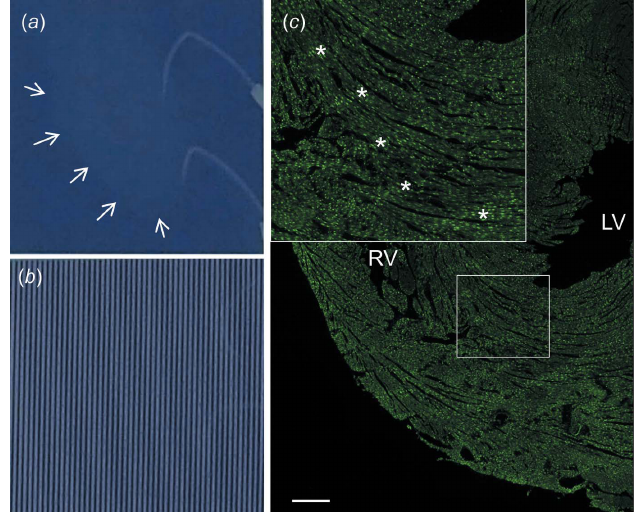
Figure 4 Heart contour (white arrows) and ECG electrodes ( a ) and complete microbeam array ( b ) registered on radiosensitive Gafchromic film [the films are of the same size in ( a ) and ( b )]. ( c ) Gamma H2AX immunostain showing the DNA double-strand breaks in the heart tissue. The bright green fluorescent dots represent nuclei harbouring the phosphorylated histone H2A in response to DNA double-strand breaks. RV: right ventricle; LV: left ventricle. Scale bar = 500 m m. Asterisks in the enlargement indicate traces of DNA double-strand breaks in the microbeam paths. The (cid:2) H2AX-positive nuclei between the microbeam paths could be partially due to differences between the patterns of muscle contraction at the time of irradiation and the time of sample fixation and partially contributed by the valley